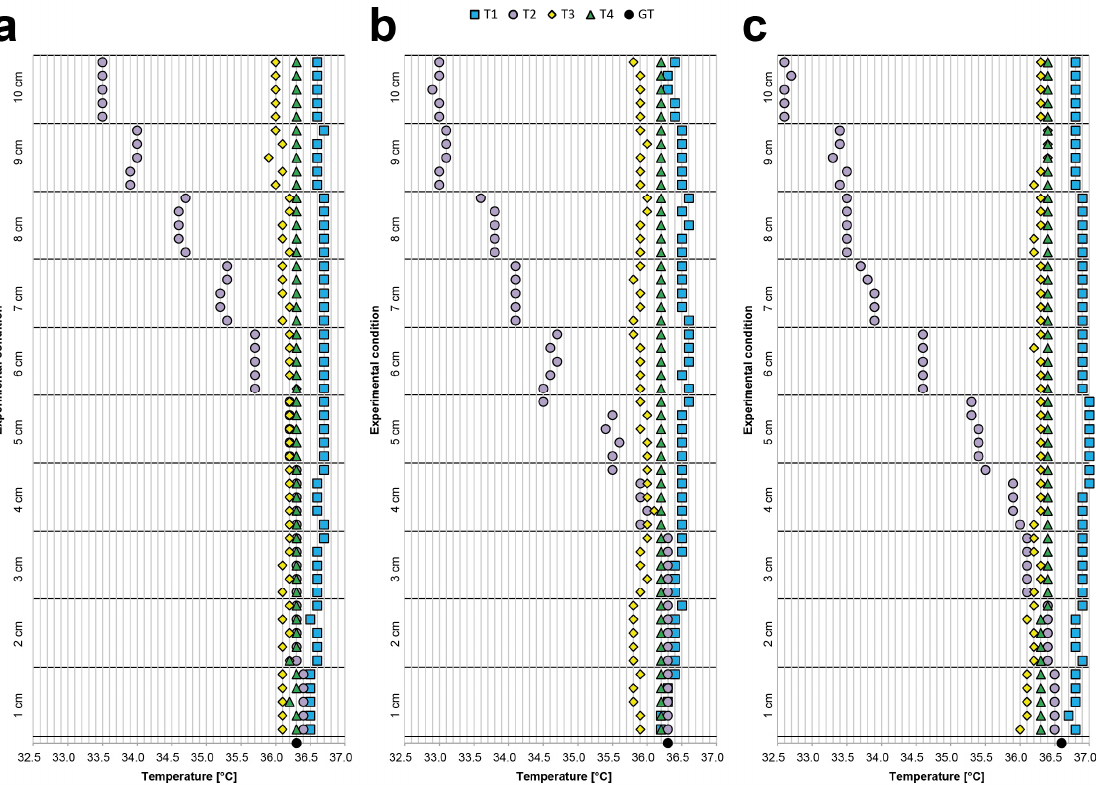
Figure 4. Visual representation of the temperature data (reported on the x -axis in °C) collected during the body–device distance experiment. We maintained the thermometer perpendicular to the forehead and, using a goniometer, acquired 5 measurements for each device in 10 different positions; ( a ) Subject1, ( b ) Subject2, and ( c ) Subject3 values.